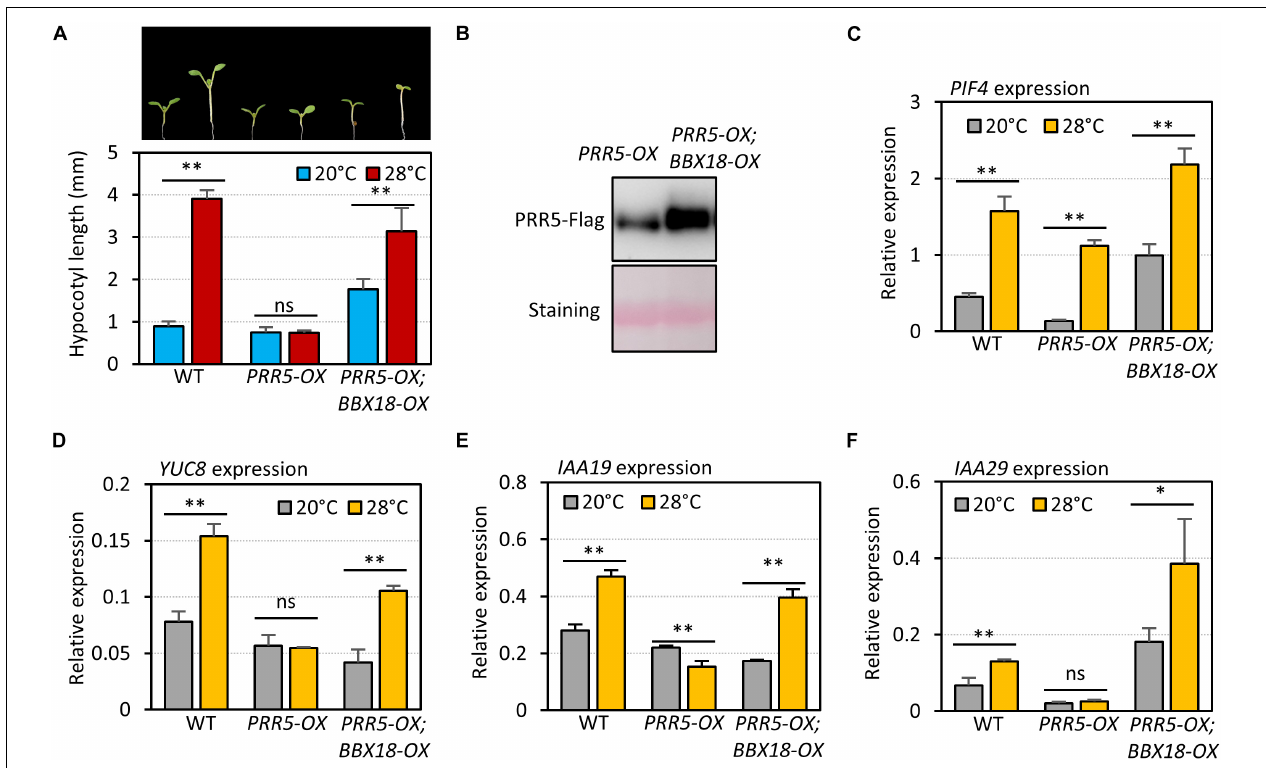
FIGURE 7 | BBX18 prevents PRR5 from inhibiting thermomorphogenesis. (A) Hypocotyl lengths of WT, PRR5-OX , and PRR5-OX;BBX18-OX seedlings grown under continuous white light at 20 ◦ C for 7 days (20 ◦ C) or 20 ◦ C for 4 days followed by 28 ◦ C for 3 days (28 ◦ C). Error bars indicate SD ( n = 10 plants). ** P < 0.01 (Student’s t -test). ns, not significant (Student’s t -test P ≥ 0.05). Representative seedlings are shown in the upper panel. (B) Immunoblot analysis of PRR5-Flag proteins in PRR5-OX and PRR5-OX;BBX18-OX plants. The plants were grown under continuous white light at 20 ◦ C for 4 days followed by 28 ◦ C for 3 days and harvested